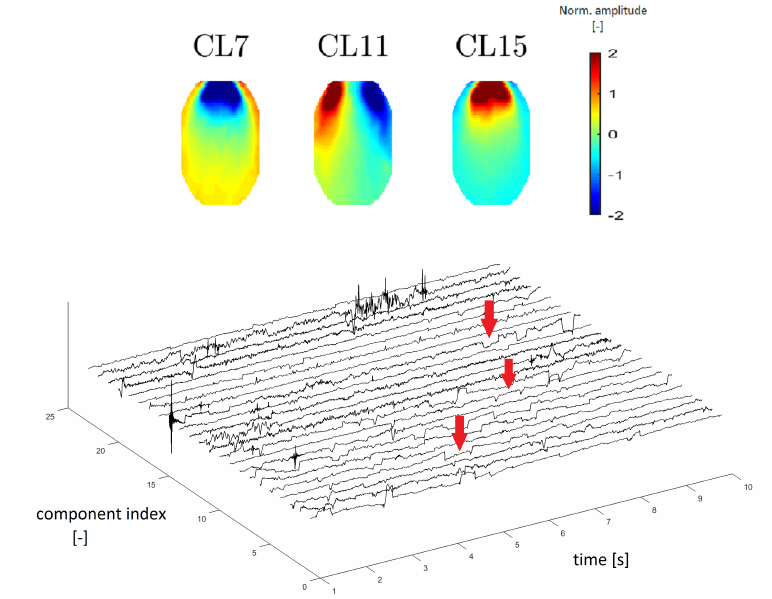
Figure 9. Topomaps of the clusters representing electrooculographic (EOG) artifacts from different eye activity ( top ). Time-series graphs of a 10-s section of the signal that were clustered into the same cluster by IC topomaps ( below ). Arrows point to an example of the EOG artifacts, which are manifested as “rectangular steps” in the time-series